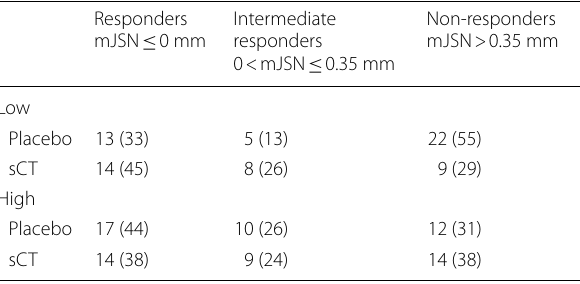
Table 3 Proportion of responders and non‑responders in high and low baseline PRO‑C2 groups